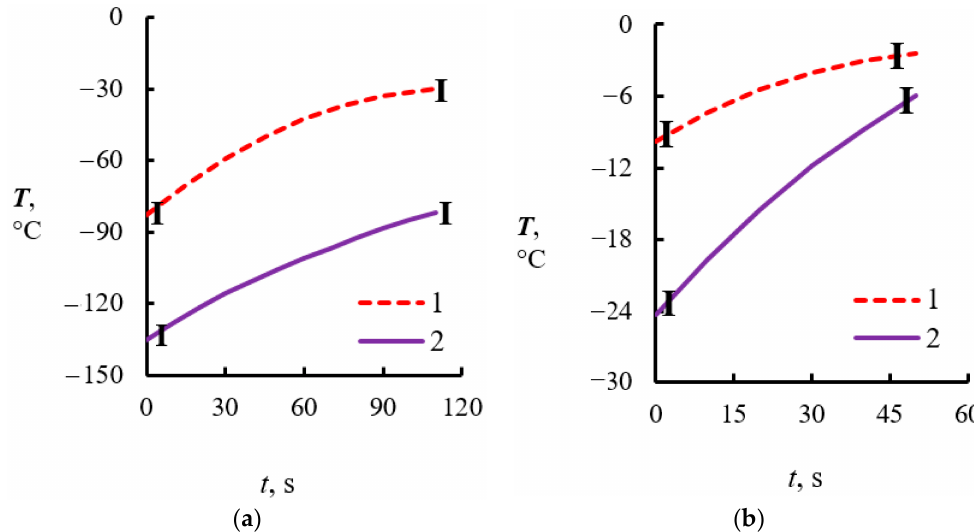
Figure 10. Temperature change in the powder layer over time during combustion of methane hydrate (1 − y = 5 mm; 2 − y = 14 mm, and y —distance from the top surface of the powder layer; thermocouples are located in the center of the tank (Figure 1)): ( a ) the velocity of the incoming flow U 0 = 0 m/s (Figure 1); and ( b ) U 0 = 0.5 m/s ( I —intervals of temperature measurement for three repeated experiments).